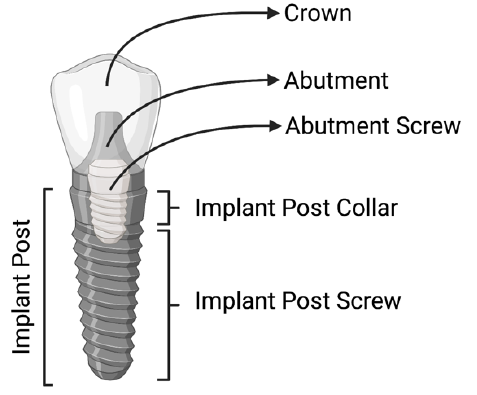
Figure 1. Dental implant structure.